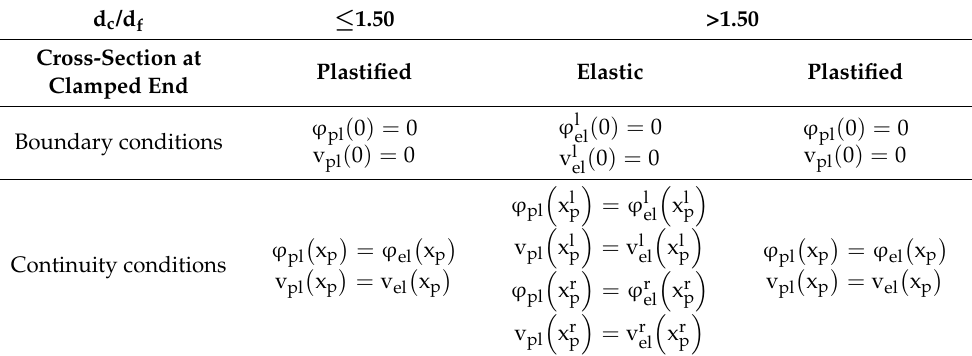
Table 1. The boundary and continuity